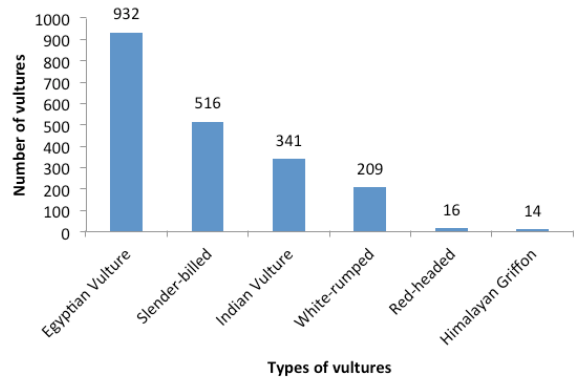
Figure 1. Species wise vulture population in Uttar Pradesh in 2011